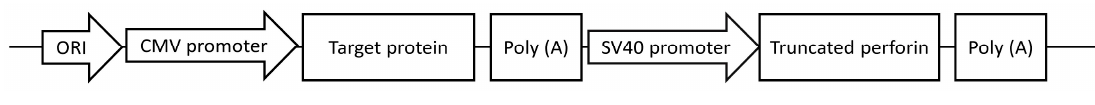
Figure 1. Schematic diagram of cytolytic bicistronic DNA plasmid (rDNA-PRF) with two different promoters and encoding protein of interest (immunogen) and truncated perforin.